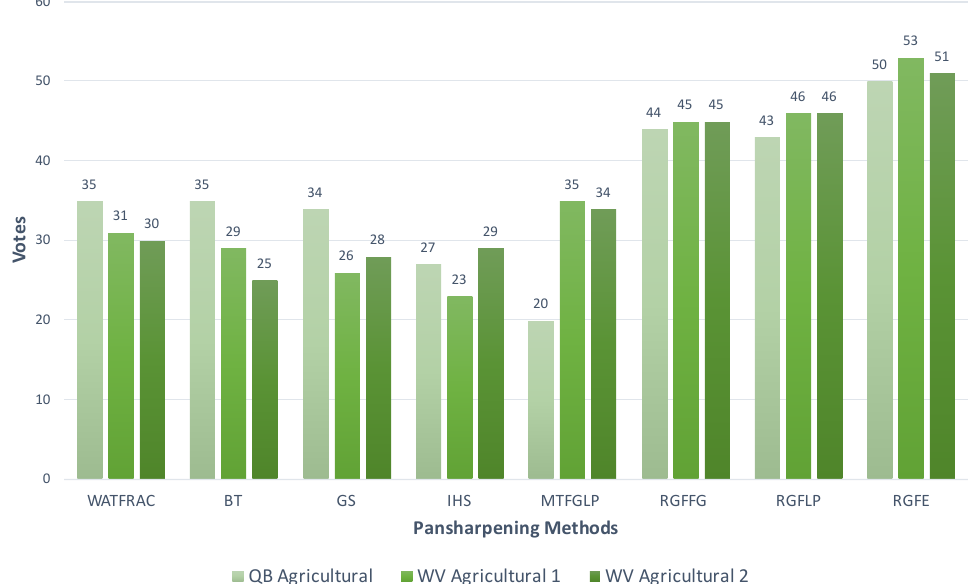
Figure 7. Comparison of the quality indexes set of pansharpened images obtained by WATFRAC, Brovey transform (BT), Grand–Schmidt (GS), intensity-hue-saturation (IHS), modulation transfer function (MTF–GLP), PSRGF FG ( σ s = 1 ) , PSRGF LP ( σ s = 1 ) and PSRGF E ( σ s = 1 ) , using